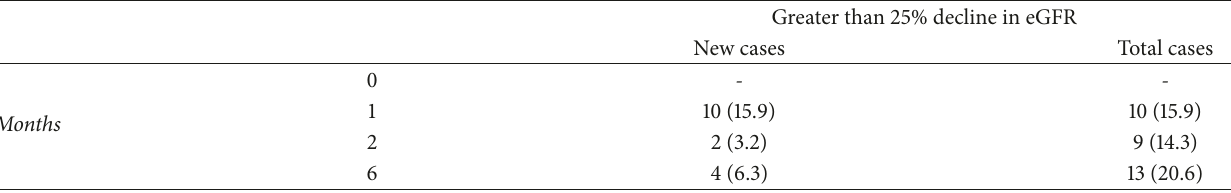
Table 3: Greater than 25% fall in estimated glomerular filtration rate of study participants in TASH, October 2017 [n =